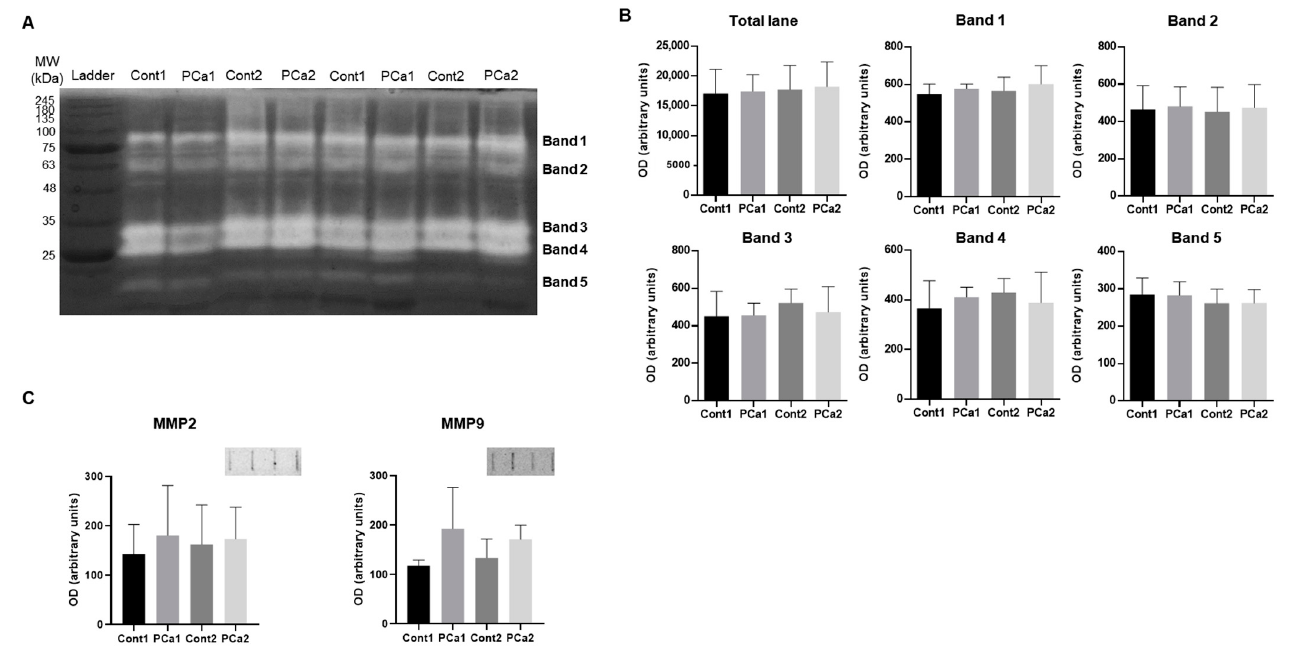
Figure 3. ( A ) Representative zymography gel of urine samples from different groups. ( B ) Optical density (OD) measurements of proteolytic bands. ( C ) Immunoblot analyses of urine levels of MMP2 and MMP9.